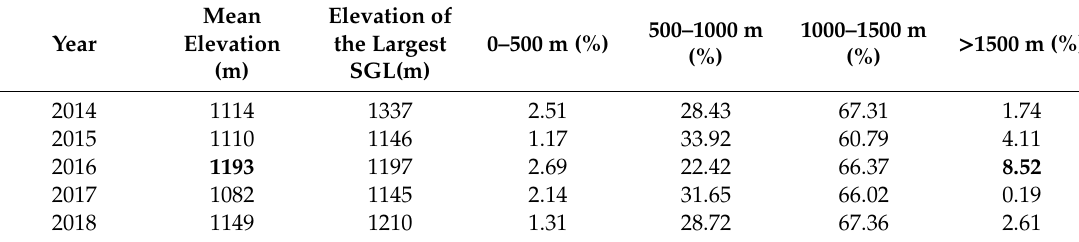
Table 5. The elevation information of SGLs from 2014 to 2018.